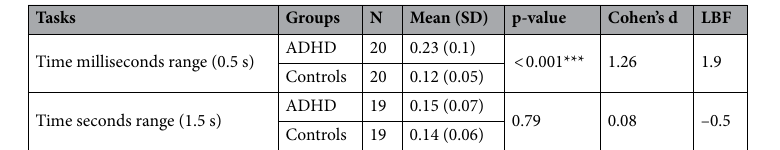
Table 2. Descriptive Statistics on time thresholds (Weber Fraction). Two tailed t-tests, α Bonferroni corrected 0.05/2 = 0.025.